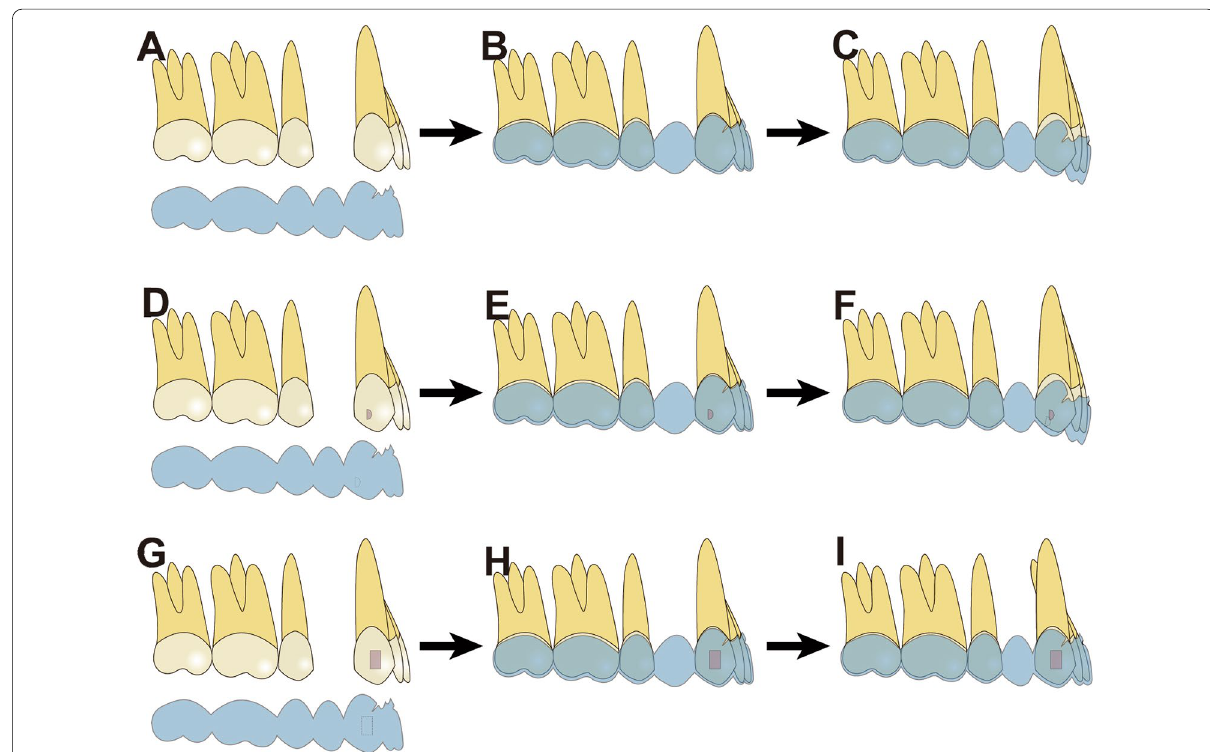
Fig. 4 Effects of canine attachments on incisor retraction. A No attachment on canines. Before wearing aligner. B The aligner was put onto the dentition. C Due to the retraction force and the additional lingual root-torquing force, the aligner tended to move incisally. D – F Optimized attachment on canine. Due to the inadequate retention offered by optimized attachments, the aligner tended to move incisally. G – I Vertical attachment on canine. Due to the adequate retention offered by the bulky vertical attachment, the aligner was retained in